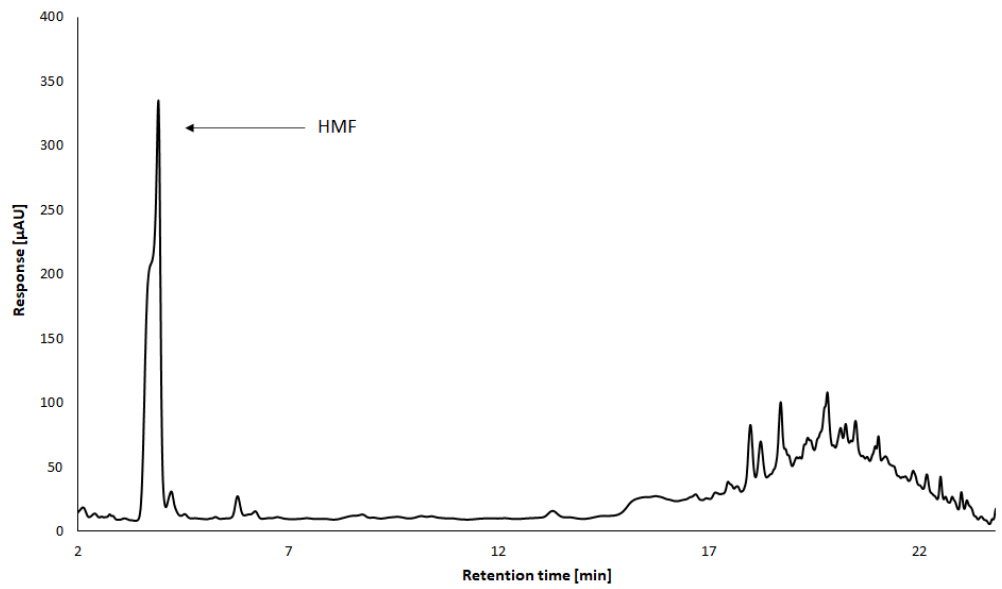
Figure 5. Analysis of HMF in TBV by HPLC-DAD method. Conditions: Luna Omega 3 µm Polar C18 100 column, mobile phase acetonitrile/water gradient (M. Kašpar, 2022, unpublished data).